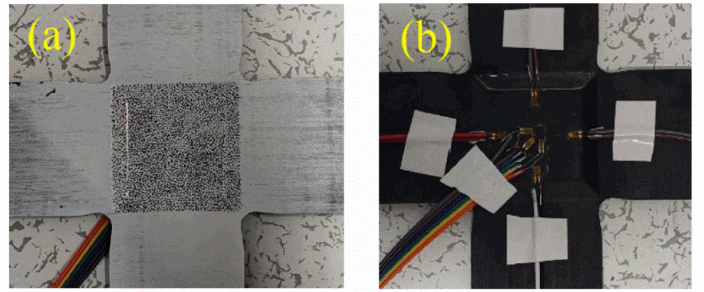
Figure 6. Images of the cruciform specimen. ( a ) With speckles painted, ( b ) with strain gauges